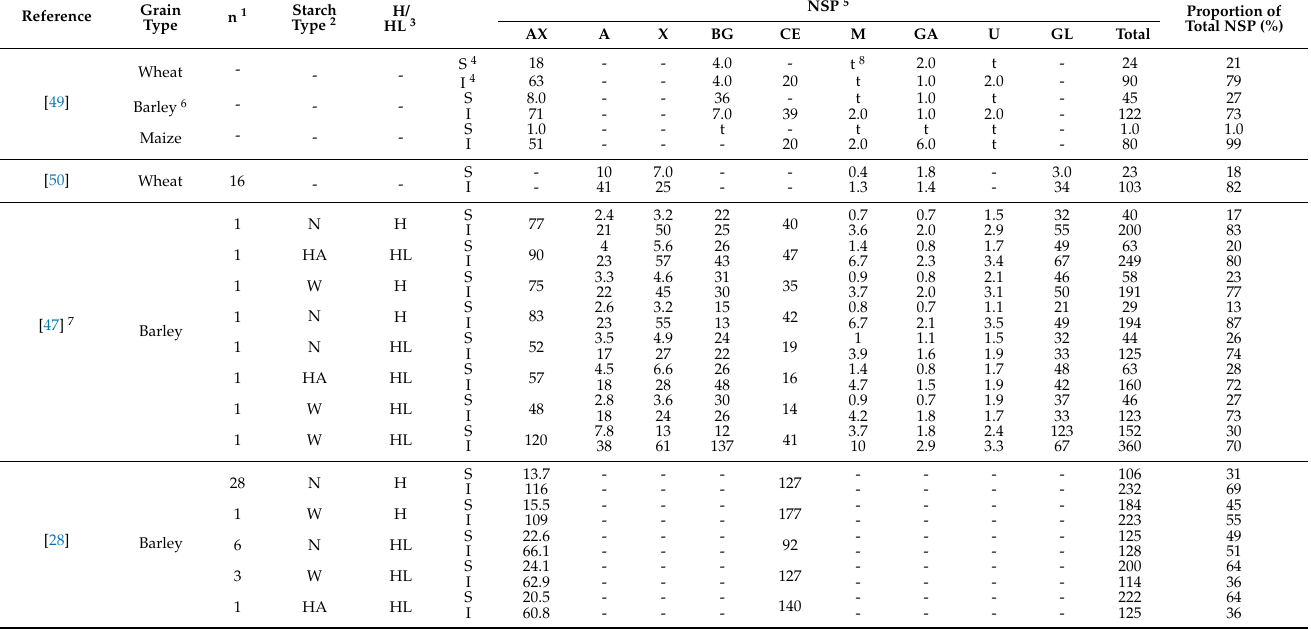
Table 3. The type and content of non-starch polysaccharides in barley, maize and wheat (g/kg, DM